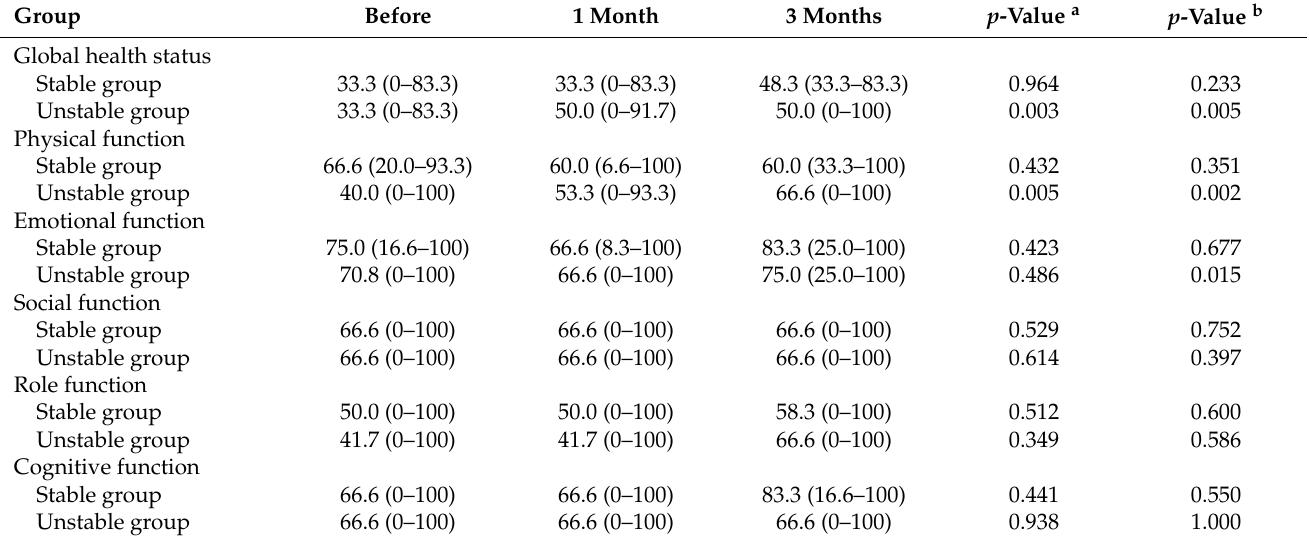
Table 7. Changes in global health status in the SINS stable and unstable